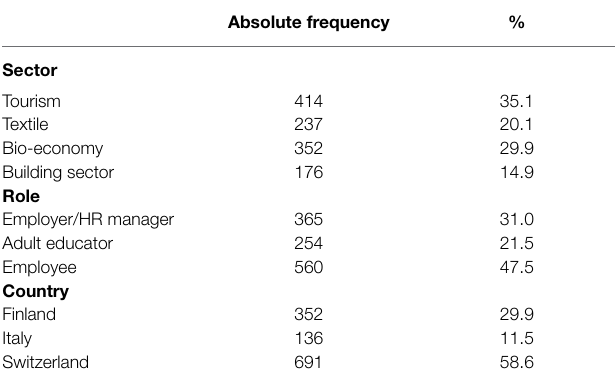
TABLE 3 | Distribution of units of meaning across sectors, nations and